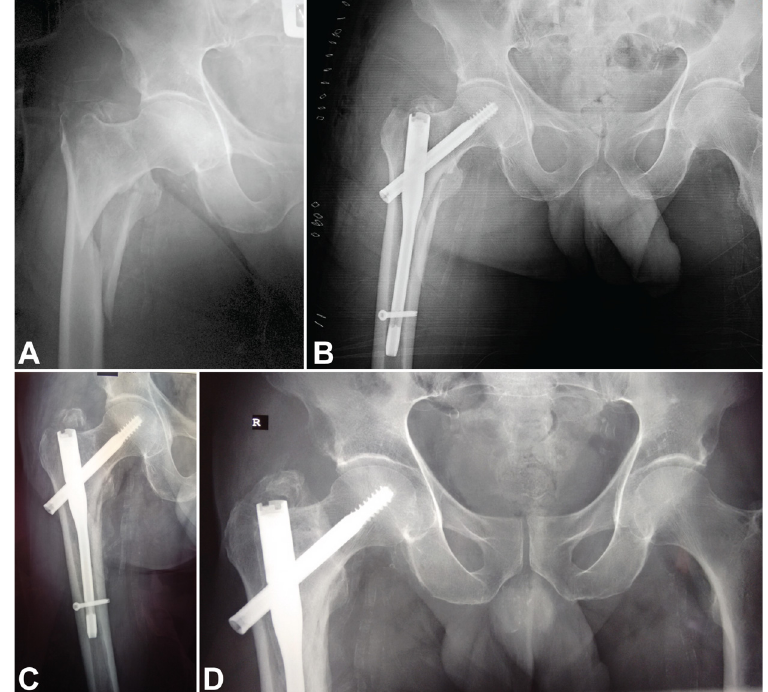
Figure 1. (A) Anteroposterior radiograph of the right hip of a 74-year-old man with an unstable pertrochanteric fracture (AO/OTA 31A2.2). (B) Postoperative radiograph after closed reduction and fracture fi xation with a short intramedullary hip nail; the distance between the distal fracture line and the distal locking screw is 3cm. (C) Anteroposterior radiograph of the right hip at 3-month follow- up shows fracture healing; the patient was weight-bearing with a cane. (D) Anteroposterior radiograph of the right hip at 12-month follow-up shows complete fracture